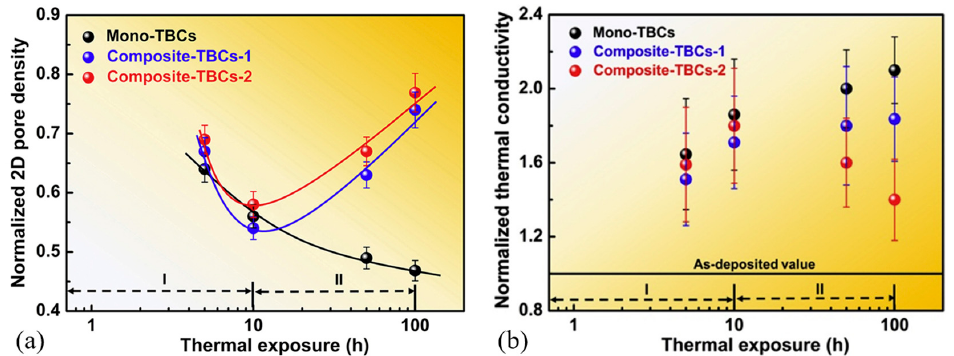
Figure 48. Changes in ( a ) 2D pore density ( b ) normalized thermal conductivity during thermal exposure [234] .